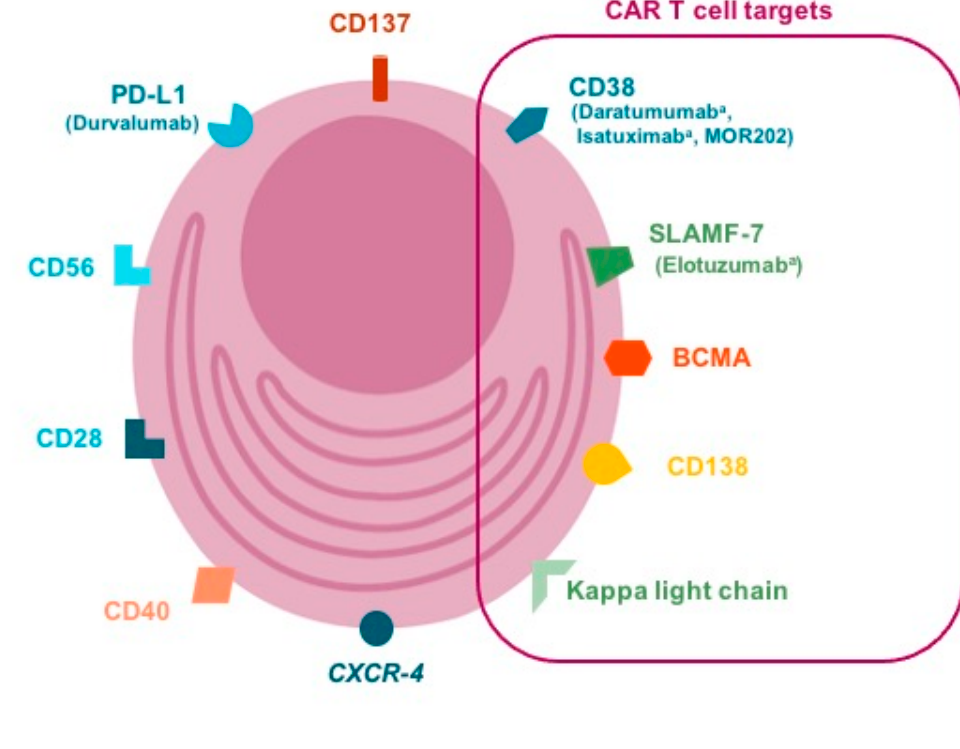
Figure 2. The figure represents some of the membrane targets expressed in the clonal plasma cell surfable that are suitable for drug development. In brackets, antibodies targeting specific antigens are included (i.e., daratumumab: anti-CD38 monoclonal antibody). CAR T cell: chimeric antigen receptor T cell; FDA: U.S. Food and Drug Administration; EMA: European Medical Agency. B-cell maturation antigen (BCMA), also named TNFRSF17 or CD269, is a membrane bound of